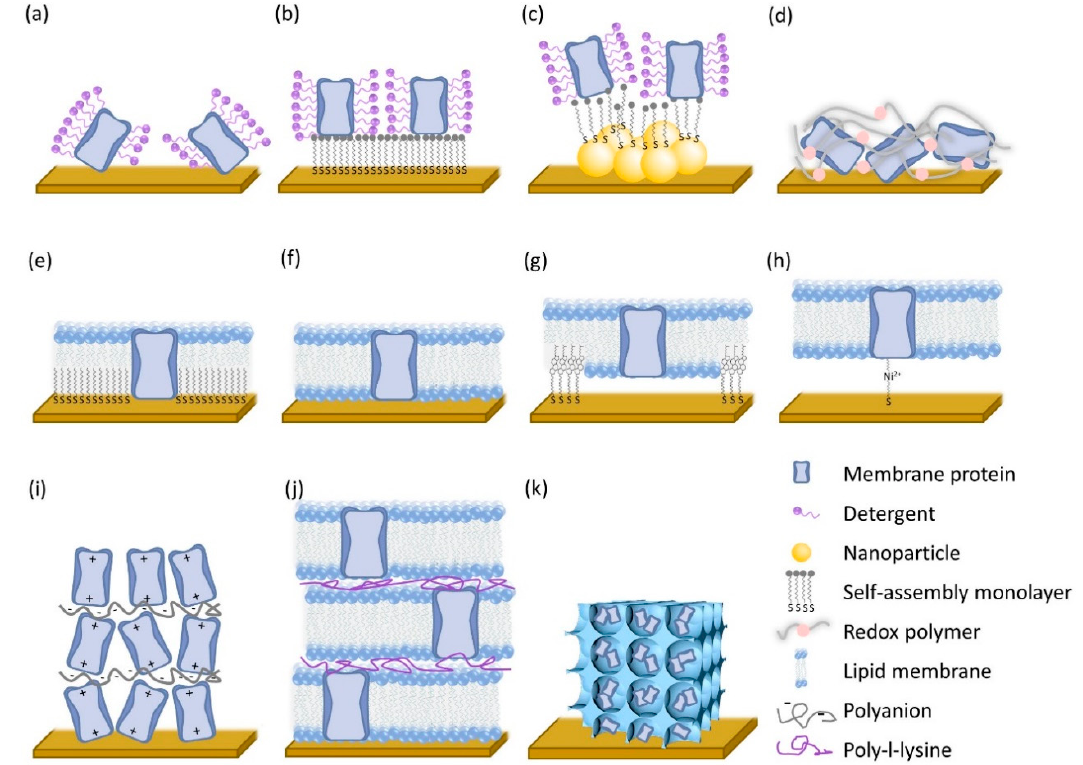
Figure 2. Overview of the strategies for membrane protein modified electrodes (not to scale). Proteins absorbed on ( a ) an unmodified electrode, ( b ) a SAM modified electrode and ( c ) a nanoparticle modified electrode. ( d ) Immobilisation of membrane proteins within a redox polymer. Examples of lipid membrane-modified electrodes: ( e ) a hybrid bilayer lipid membrane (hBLM), ( f ) a solid supported bilayer lipid membrane (sBLM), ( g ) a tethered bilayer lipid membrane (tBLM) and ( h ) a protein tethered bilayer lipid membrane. (ptBLM). ( i ) Layer-by-layer deposition of alternating charged films. ( j ) Multilayered lipid membrane stacks. ( k ) 3D structure electrode for protein